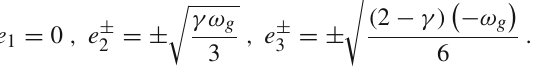
(cid:5) (cid:3) (cid:4) ω ,ω = , m g 3